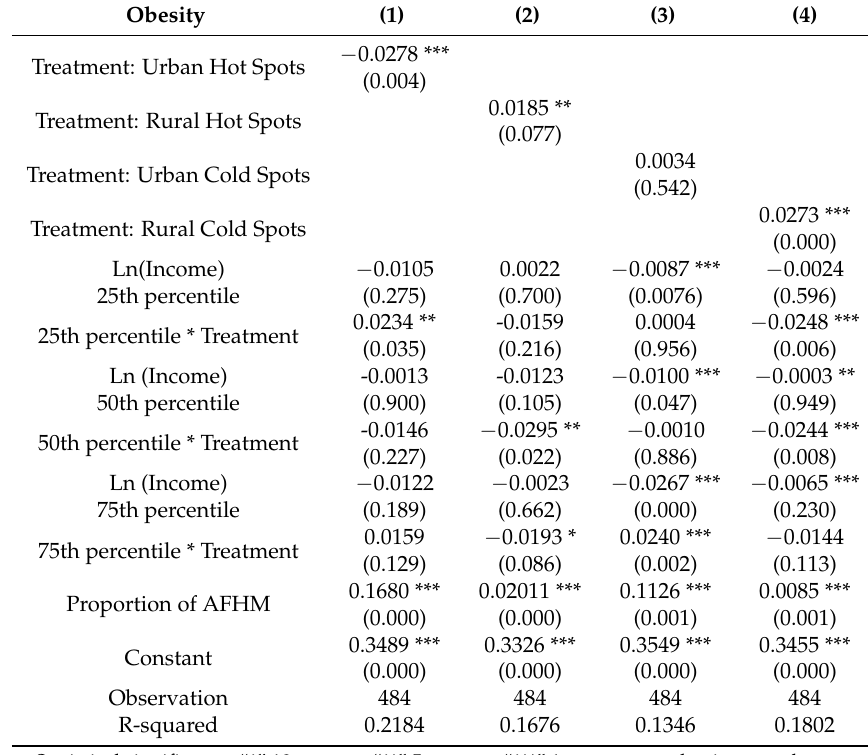
Table 2. The impacts of urban and rural hot (and cold) spots on obesity